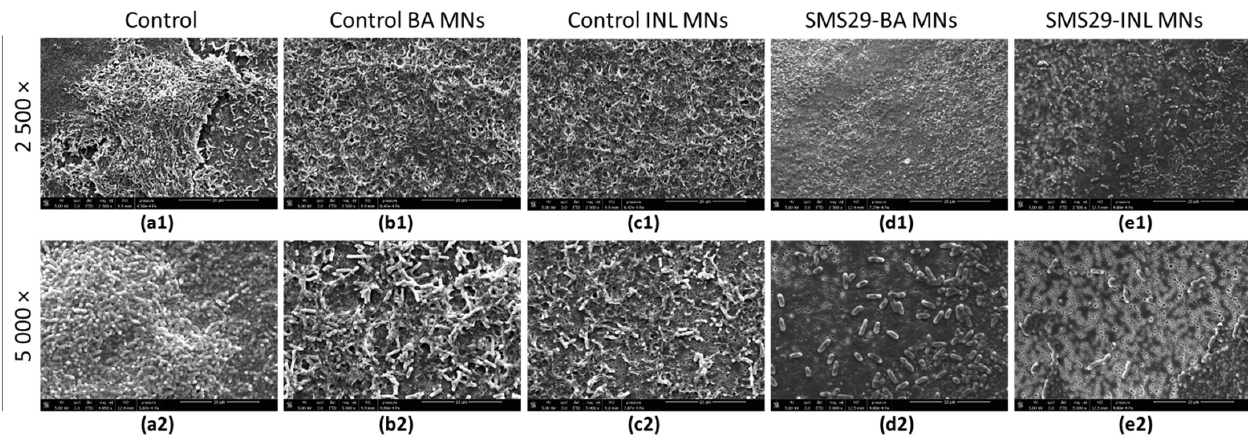
Figure 8. SEM micrographs of untreated and phage vB_PaeM-SMS29 treated (24 h treated) P. aeru- ginosa PAO1 biofilms. Biofilms after treatment for 24 h with ( a ) no phages and no MNs (control) ( b )